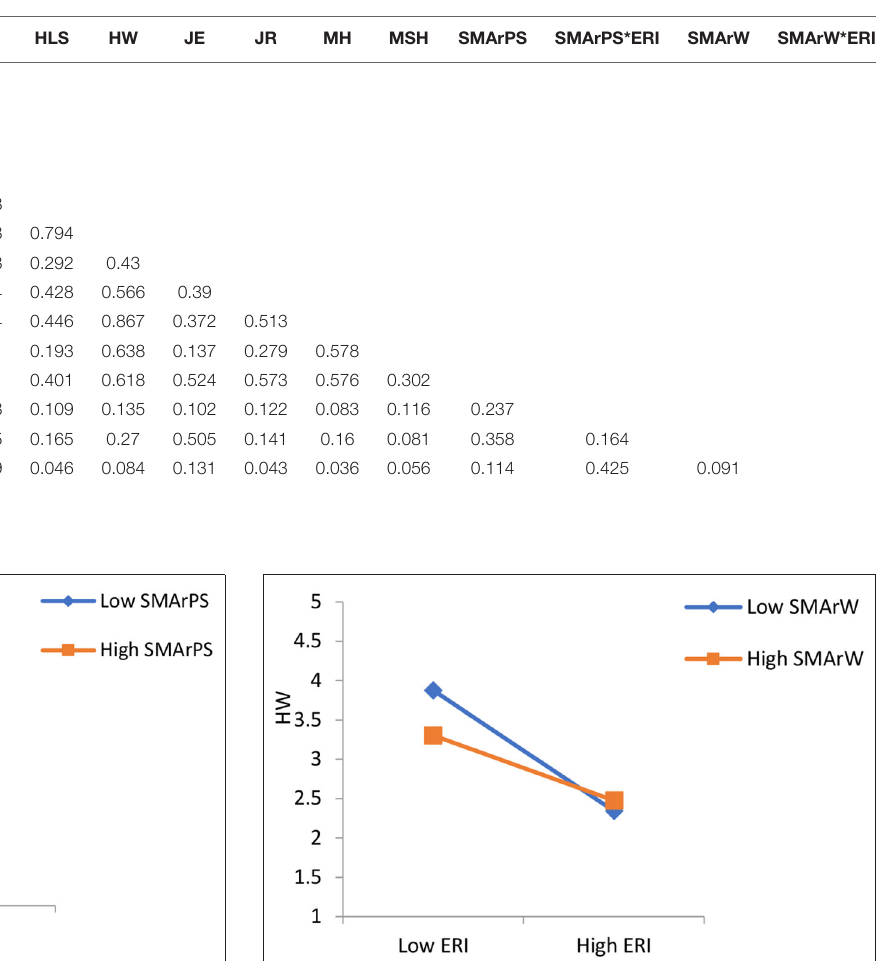
TABLE 6 | Hetrotrait-monotrait ratio.